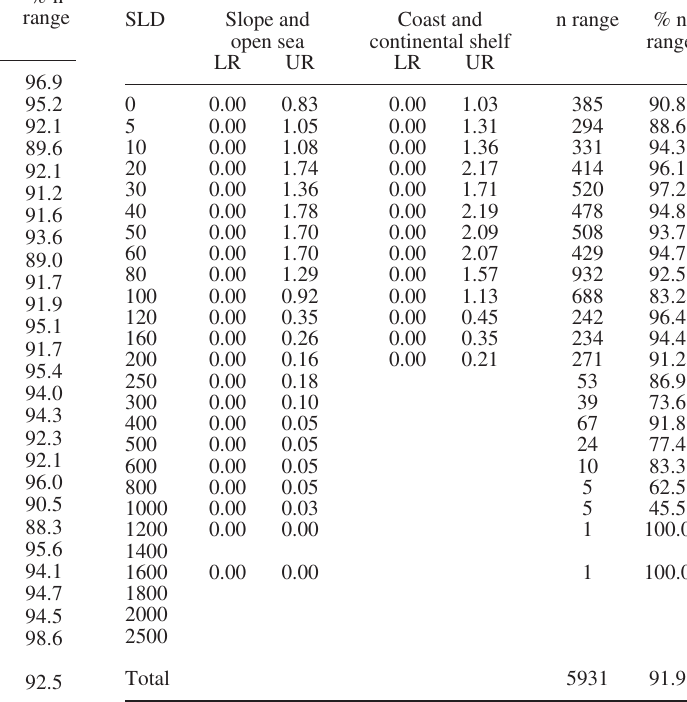
Table 16. – Dissolved oxygen (ml l -1 ) ranges in the NW Mediter- ranean Sea. Headers as in Table 7. SLD Slope and